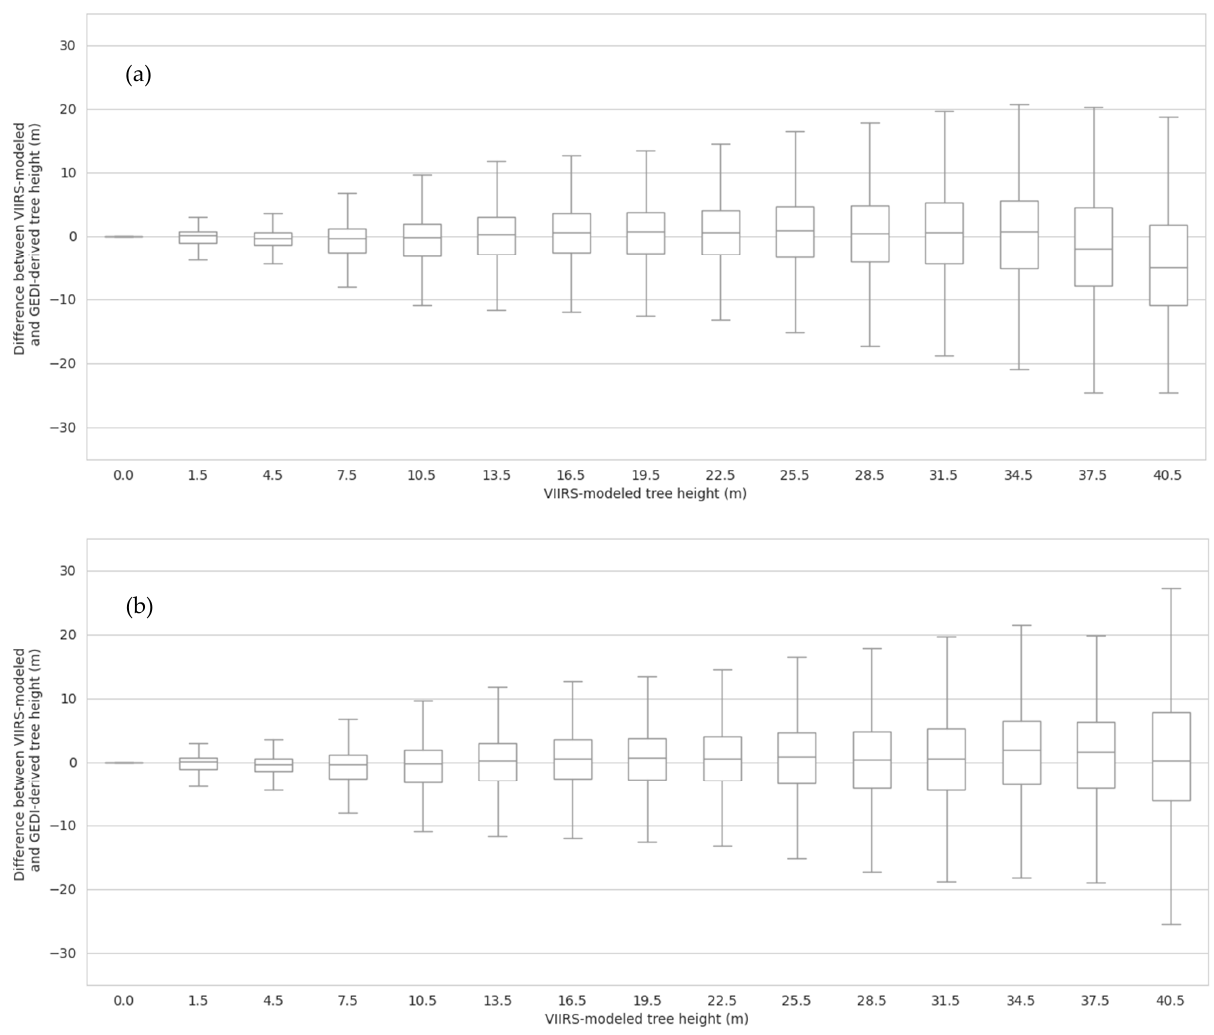
Figure 9. Distribution of residuals between ( a ) 2020 VIIRS and GEDI-derived canopy height prior to mean bias adjustment; and ( b ) 2020 VIIRS and GEDI-derived canopy height post mean bias ad- justment.